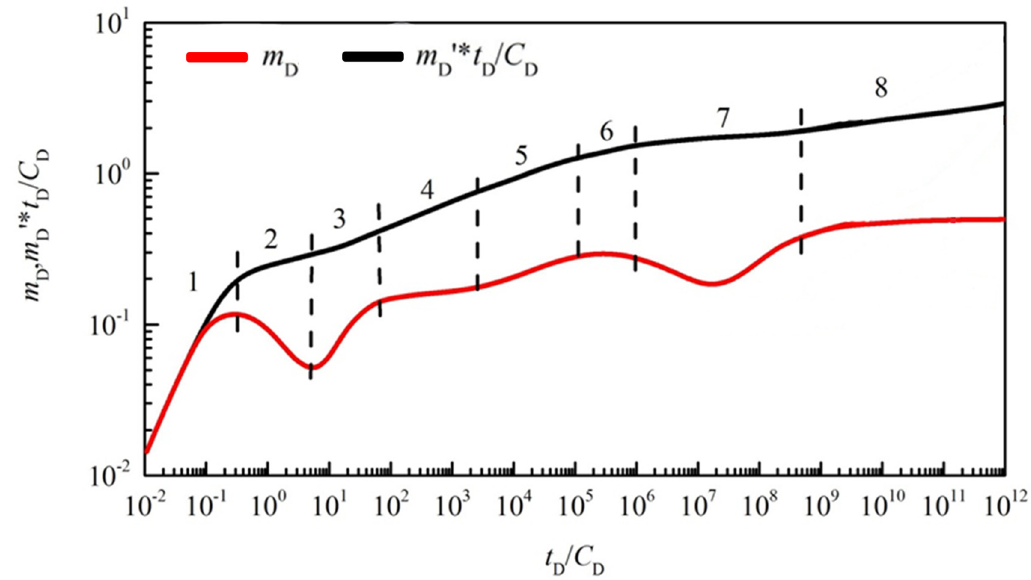
Figure 2. Dimensionless pseudo-pressure and pseudo-pressure derivative characteristic curve of gas-water two-phase multi-stage fractured horizontal wells in the shale gas reservoir. Based on the Duhamel principle, the Blasingame production decline characteristic curve of the gas–water two-phase fractured horizontal wells in dual-medium shale gas reservoir with t Dd as the abscissa and q Ddi and q (cid:48) Ddi as the vertical coordinates can be further obtained as shown in Figure 3.